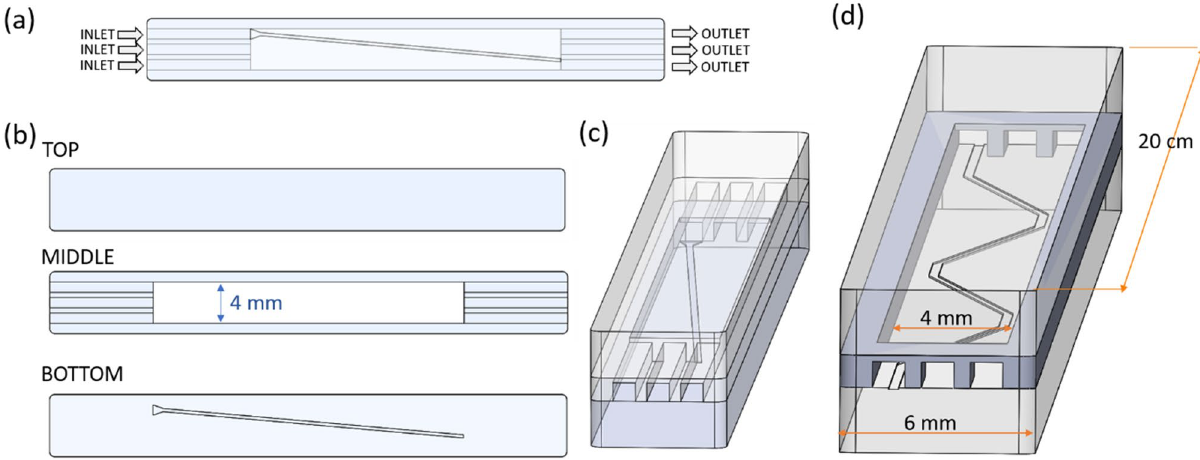
Figure 1. Scheme of the chip: ( a ) top view, ( b ) parts of the chip, ( c ) side view, ( d ) a zig-zag chip [not to scale: the zig-zag chip is longer than a single-rail chip in ( c ) (50